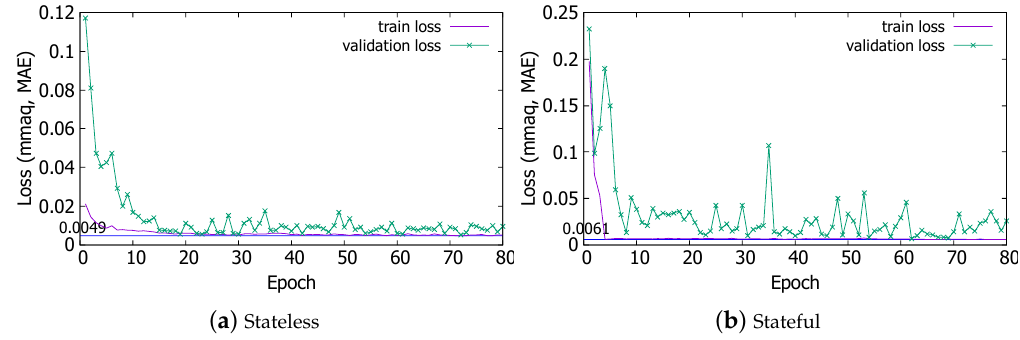
Figure 11. Loss of train and validation.